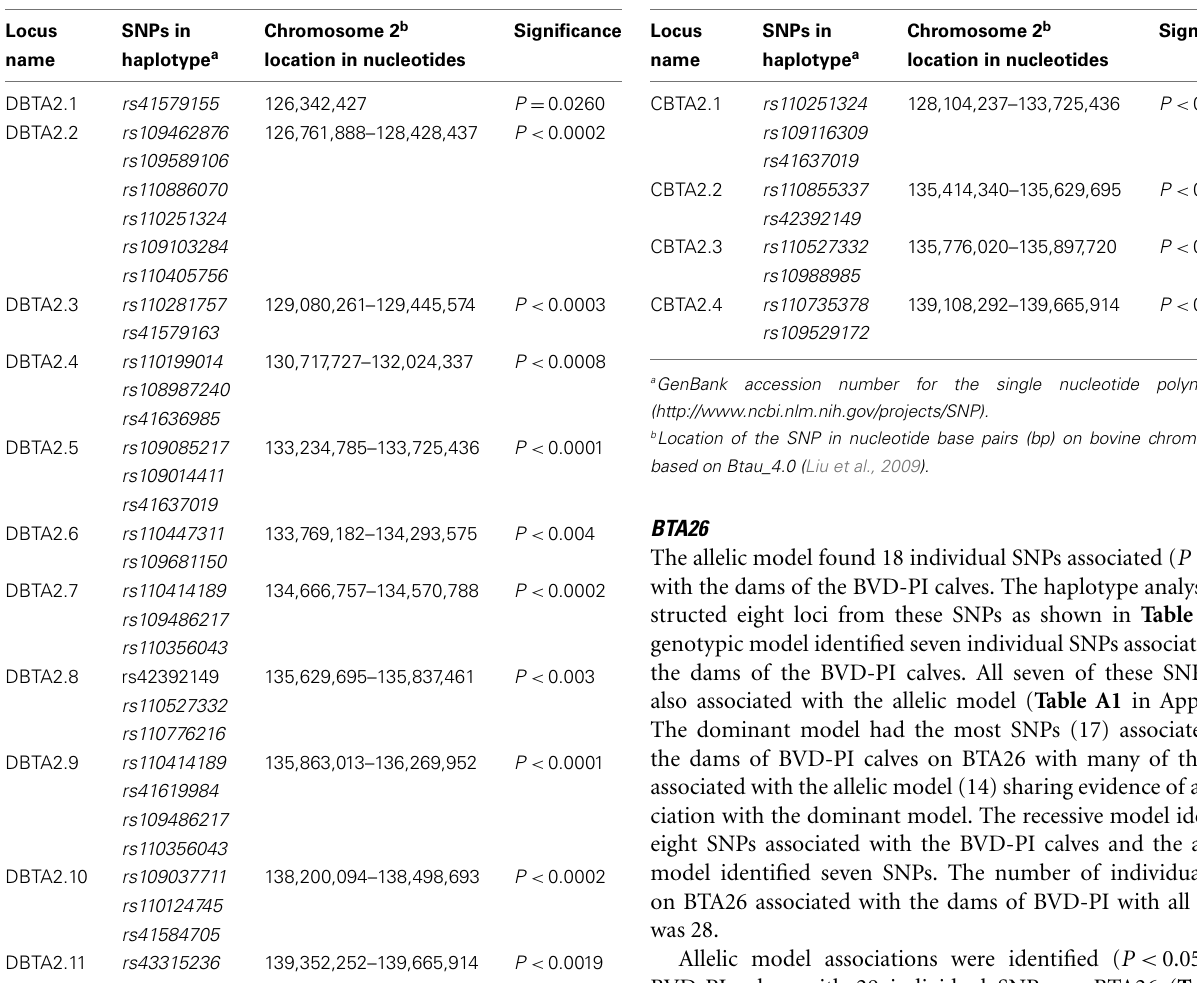
Table 2 | Haplotypes associated with bovine viral diarrhea persistently infected calves on BTA2 using the allelic